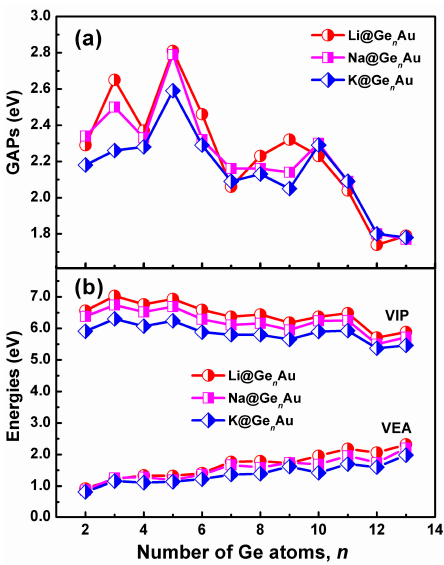
Figure 3. Size dependences of ( a ) HOMO-LUMO gaps (GAPs), and ( b ) vertical ionization potentials (VIP) and vertical electron affinities (VEA) for the AM@Ge n Au ( n = 2–13) clusters, obtained by using the hybrid B3LYP functional, in conjunction with the Def-TZVP basis set.